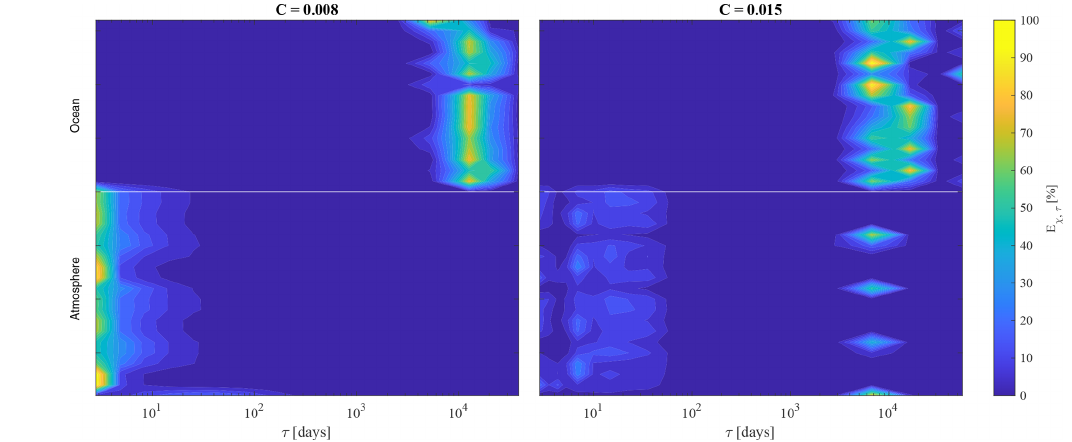
Figure 3. Relative contribution (in percentage) E χ,τ of each variable χ = { ψ a ,i ,θ a ,i ,(cid:57) o ,i ,T o ,i } in dependence on the mean timescale τ . Panels (a) and (b) refer to the two values of the friction coefficient C = 0 . 008 and C = 0 . 015, respectively. The white line separates the atmospheric variables from the oceanic ones.